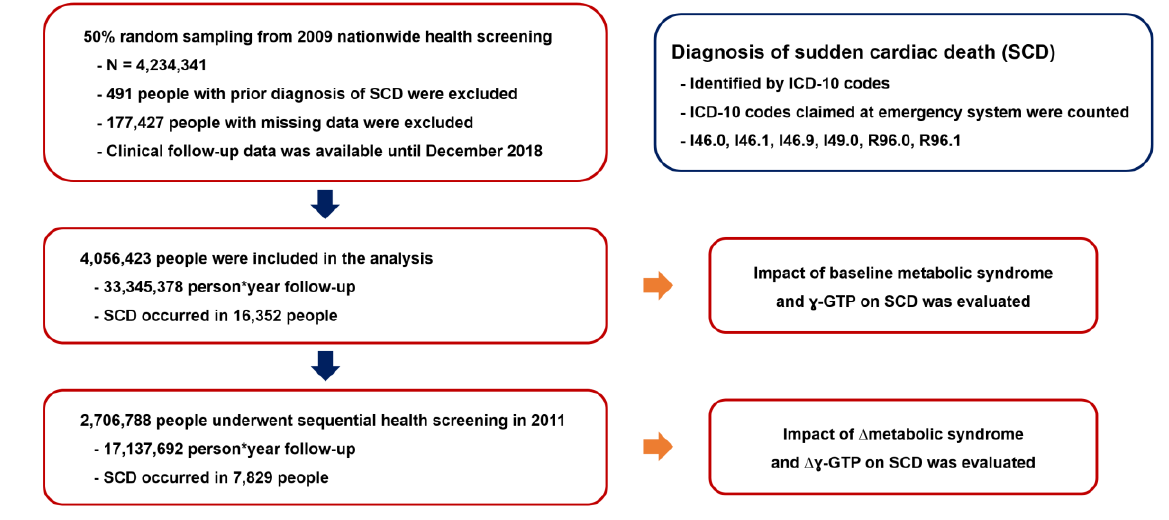
Figure 1. Study flow. ɣ -GTP: gamma-glutamyl transferase; ICD-10: International Classification of Disease, tenth edition; SCD: sudden cardiac death. Table 1. Baseline characteristics of SCD victims.